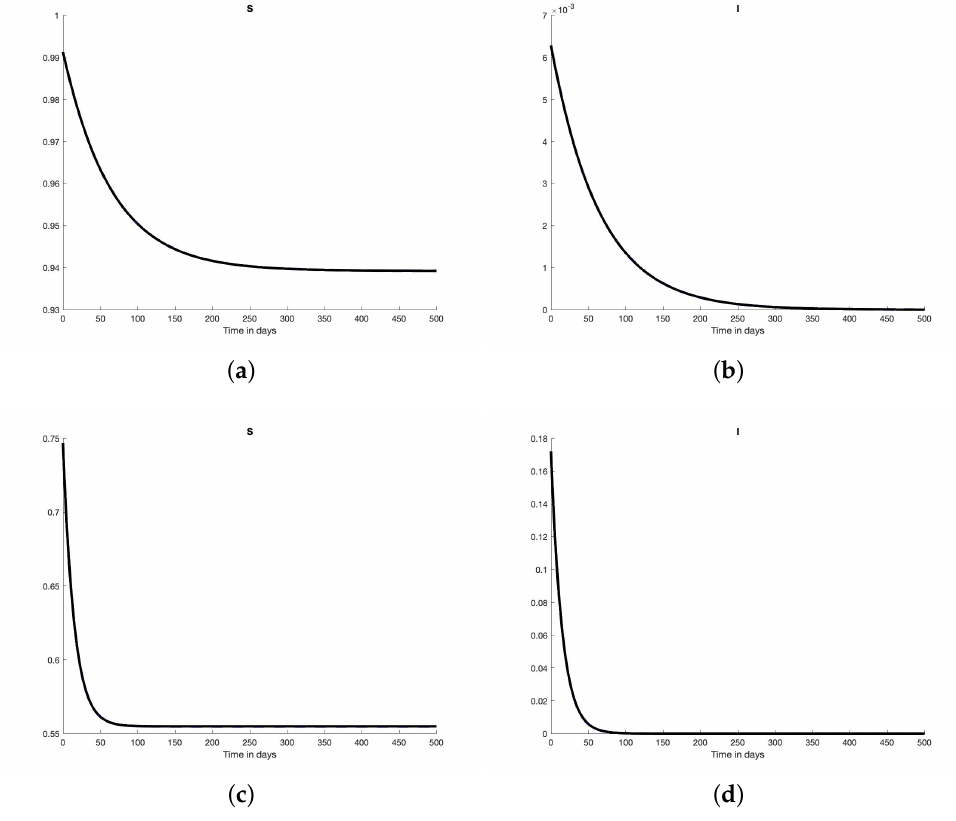
Figure 2. Scenario 1: States. ( a ) 35 days later: S and S ∗ (- -); ( b ) 35 days later: I and I ∗ (- -); ( c ) 45 days later: S and S ∗ (- -); ( d ) 45 days later: I and I ∗ (-